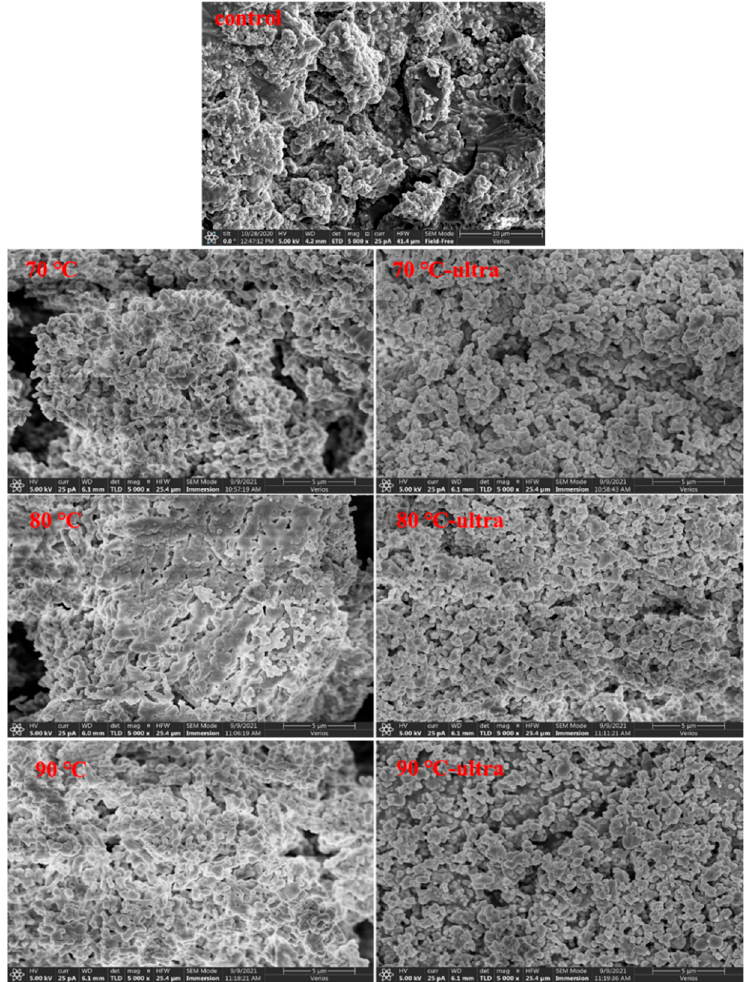
Figure 5. Scanning electron microscopy of different coconut globulin samples (ultra: 53 kHz, 40 w / l , 20 min; 70, 80 and 90 °C represent preheating for 20 min).